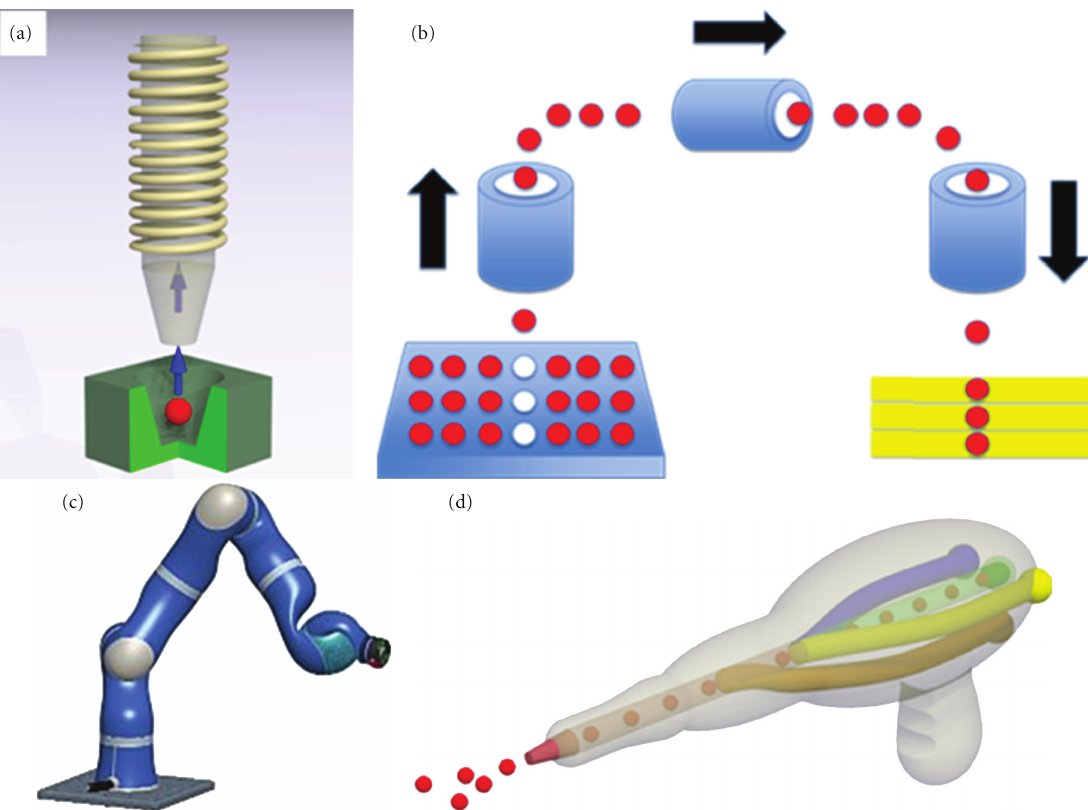
Figure 9: Design elements of a clinical robotic bioprinter. (a) Tissue spheroids harvester based on magnetic levitation of tissue spheroids; (b) Principal scheme of clinical robotic bioprinter demonstrating how tissue spheroids can be harvested from multiwells, translocated and dispensed in living tissue using magnetic levitation; (c) Elegant robotic hand developed by group of robotics and mechanotronics at German Aerospace Institute (http://www.dlr.de/rm/en/desktopdefault.aspx/tabid-3803/6175 read-8961/) which can be employed as an essential component in robotic clinical bioprinter for automated nozzle positioning; (d) Computer-aided design of nozzle of clinical robotic bioprinter containing several channels: two channels for fibrinogen and thrombin, one channel for tissue spheroids and additional channel for pressurized air for enabling fibrin hydrogel